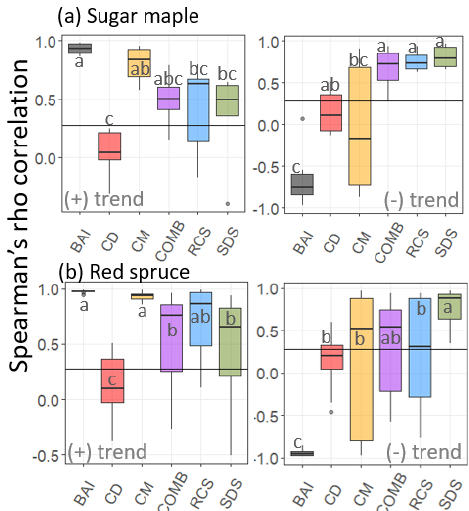
Figure 5. Standardized chronologies produced by each standardiza- tion method applied to tree ring series from (a) sugar maple ( n = 6) and (b) red spruce ( n = 12) stands. Solid lines represent the re- sultant model-wise mean chronologies across all stands considered while ribbons represent respective 95% confidence intervals. Dot- ted lines indicate the standardized positive (left side) or negative (right side) logistic trend that was added to the raw tree ring